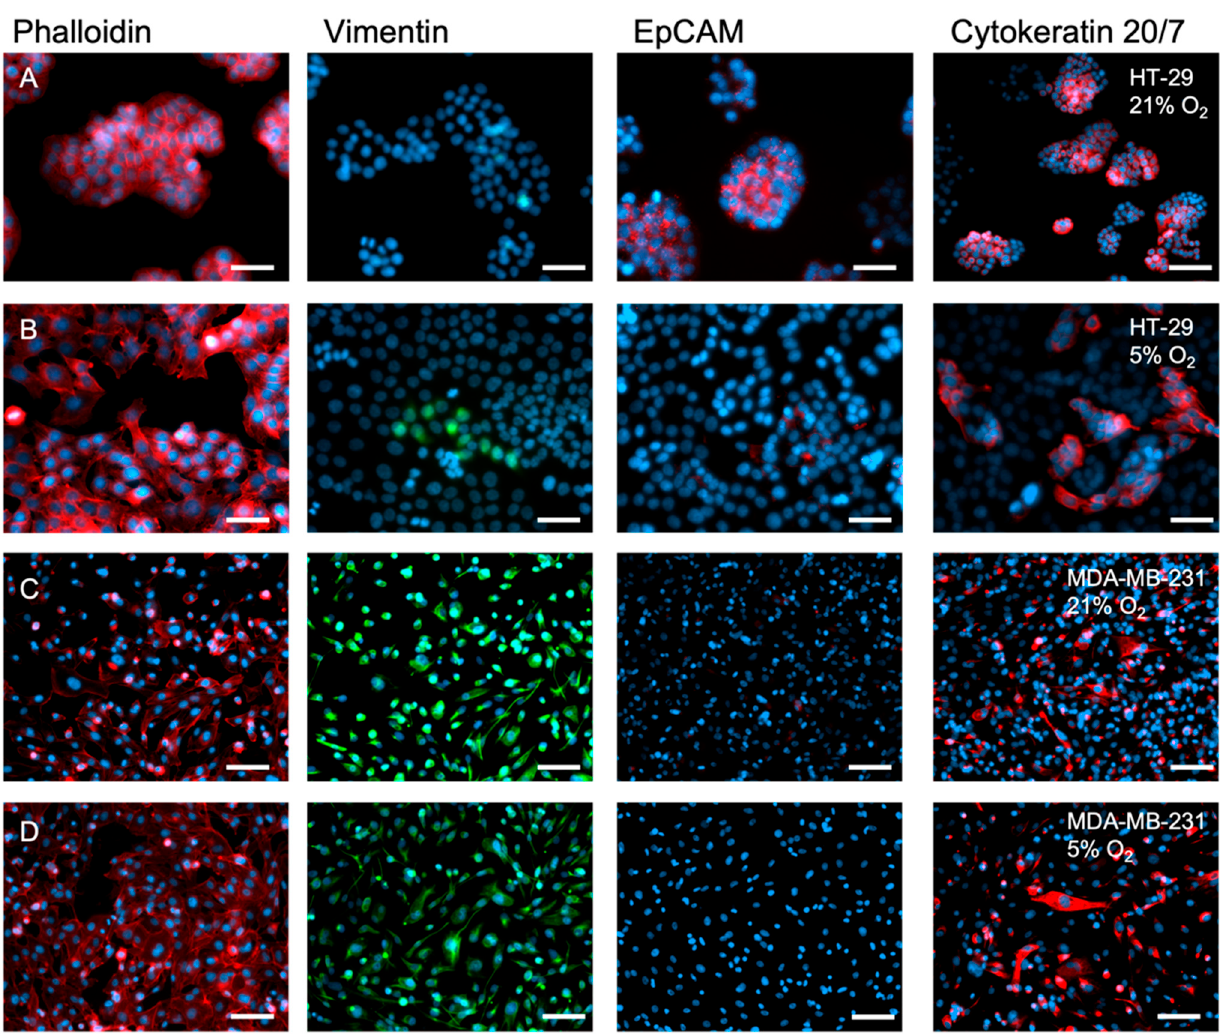
Figure 3. EMT markers in 2D monolayers of HT-29 and MDA-MB-231 cells cultured within differing oxygen environments. ( A ) HT-29 cells grown for 7 days in normoxia (21% O 2 ). ( B ) HT-29 grown for 7 days physiological hypoxia (5% O 2 ). ( C ) MDA-MB-231 cells grown for 7 days in normoxia (21% O 2 ). ( D ) MDA-MB-231 cells in physiological hypoxia (5% O 2 ). Red = Phalloidin, EpCAM, or CK20/7; green = Vimentin; blue = DAPI; and scale bar = 50 µm.